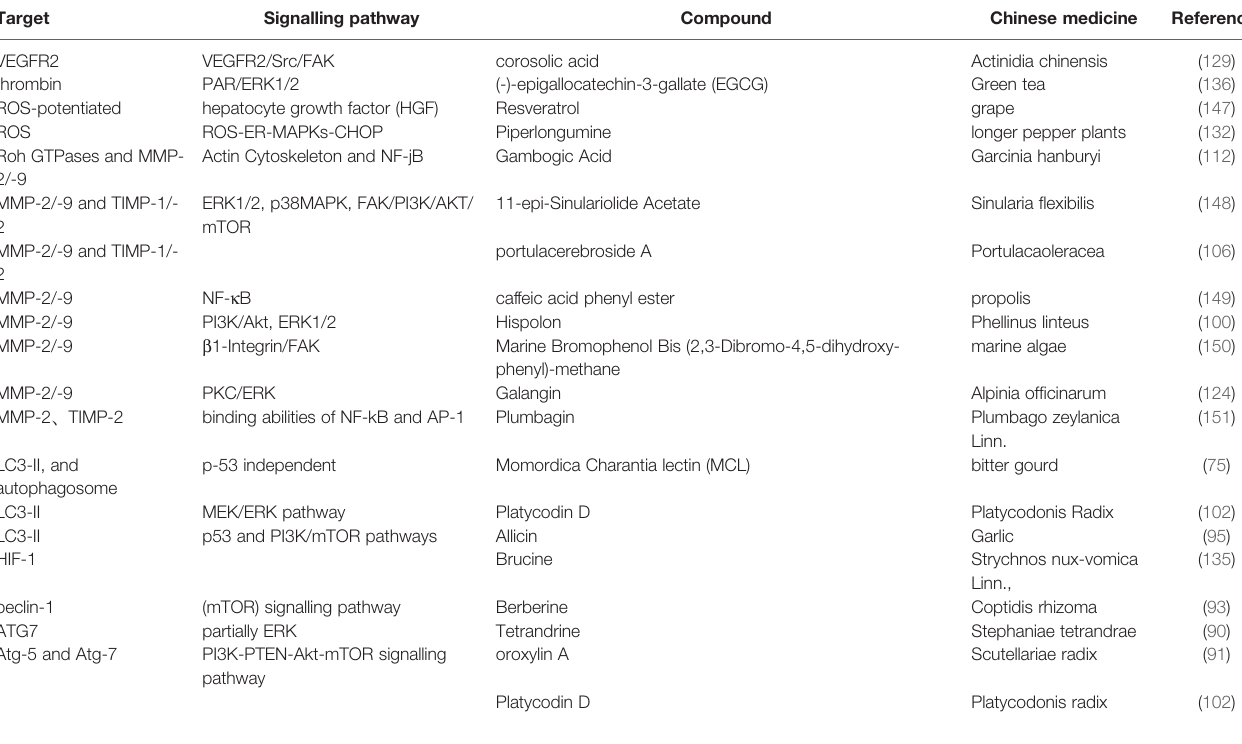
TABLE 4 | The targets and pathways of natural compounds in the process of inhibiting migration and invasion in